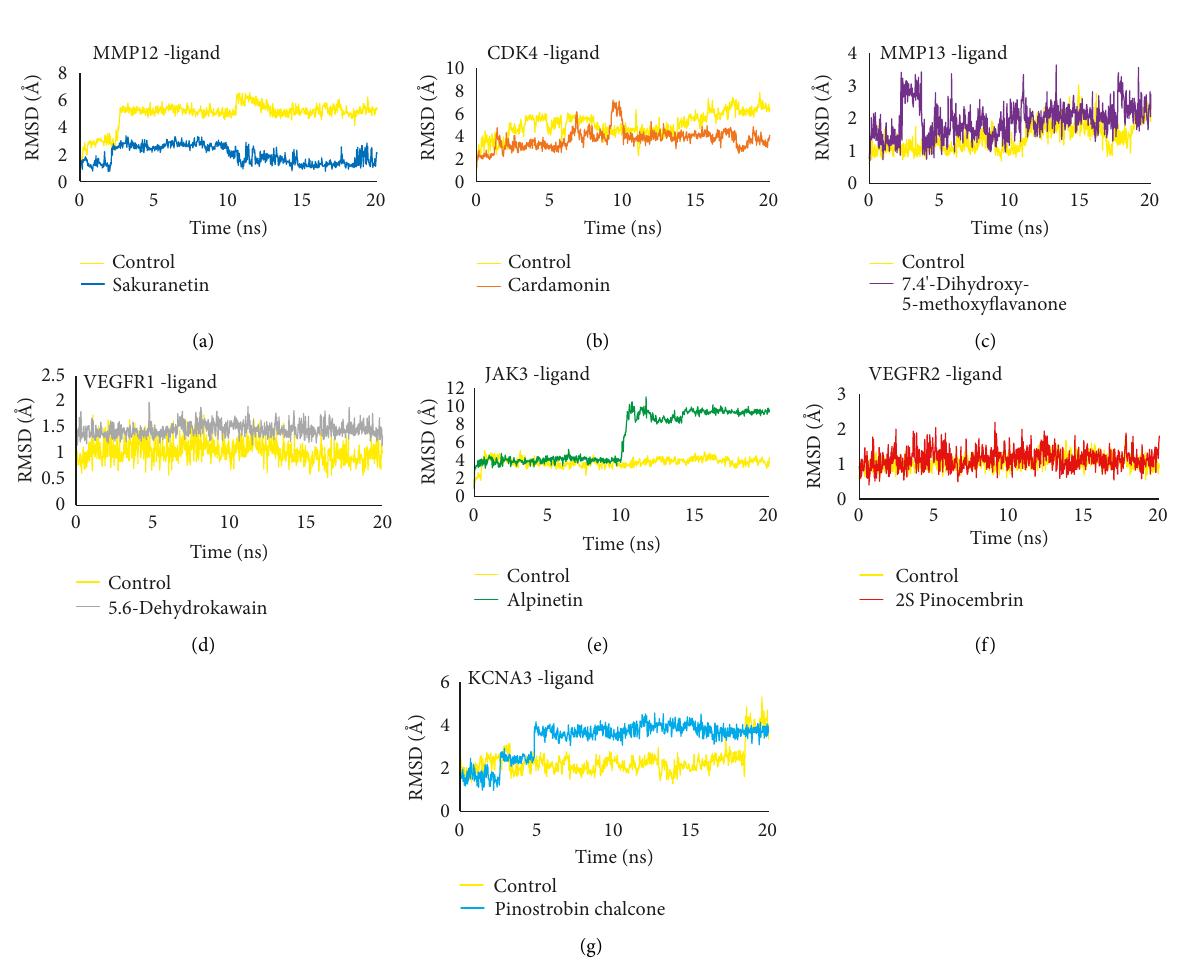
Figure 5: RMSD ligand movement of the protein-compound complex.